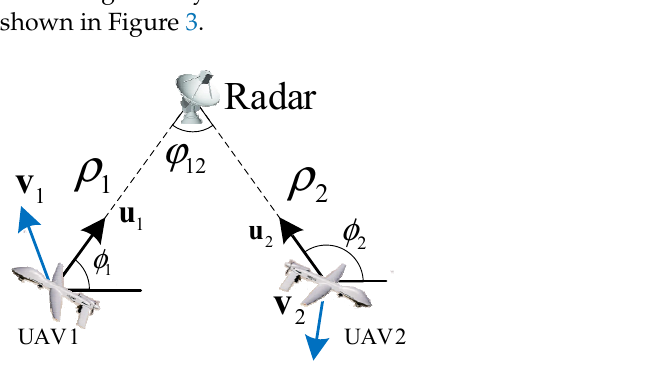
Figure 3. Geometry and vector notations for radar location.